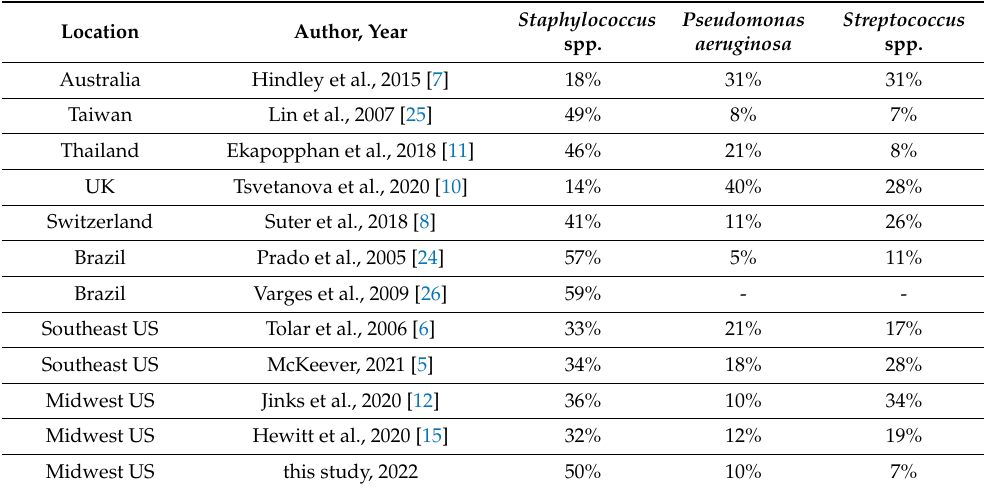
Table 4. Distribution of the most common bacterial species from canine corneal ulcers across various geographical locations.